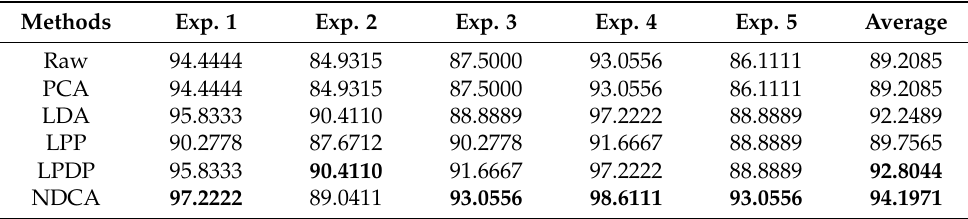
Table 6. Classification accuracy (%) of different dimension reduction algorithms using NN as the classifier.